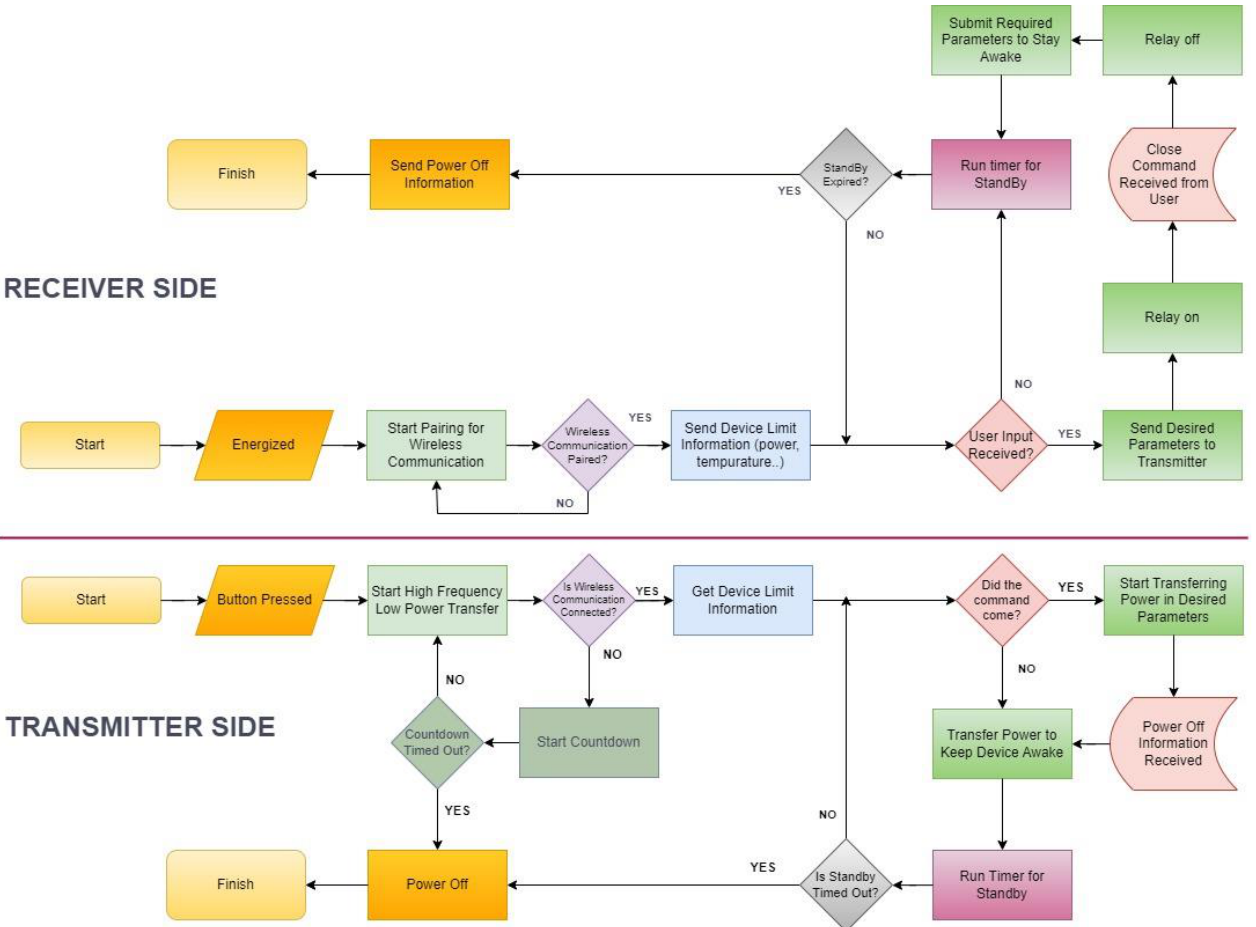
Figure 10. Operating flow chart of WPT system designed for kettle.